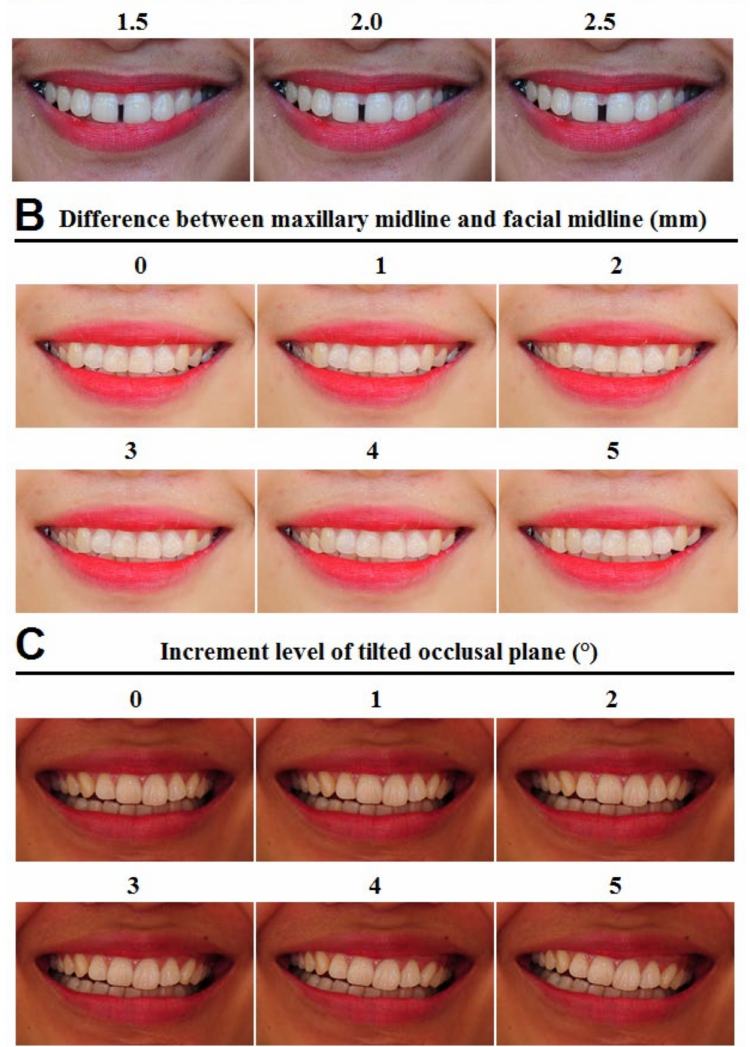
Figure 3. Maxillary midline diastema ( A ), maxillary midline shift ( B ), and tilted occlusal plane ( C